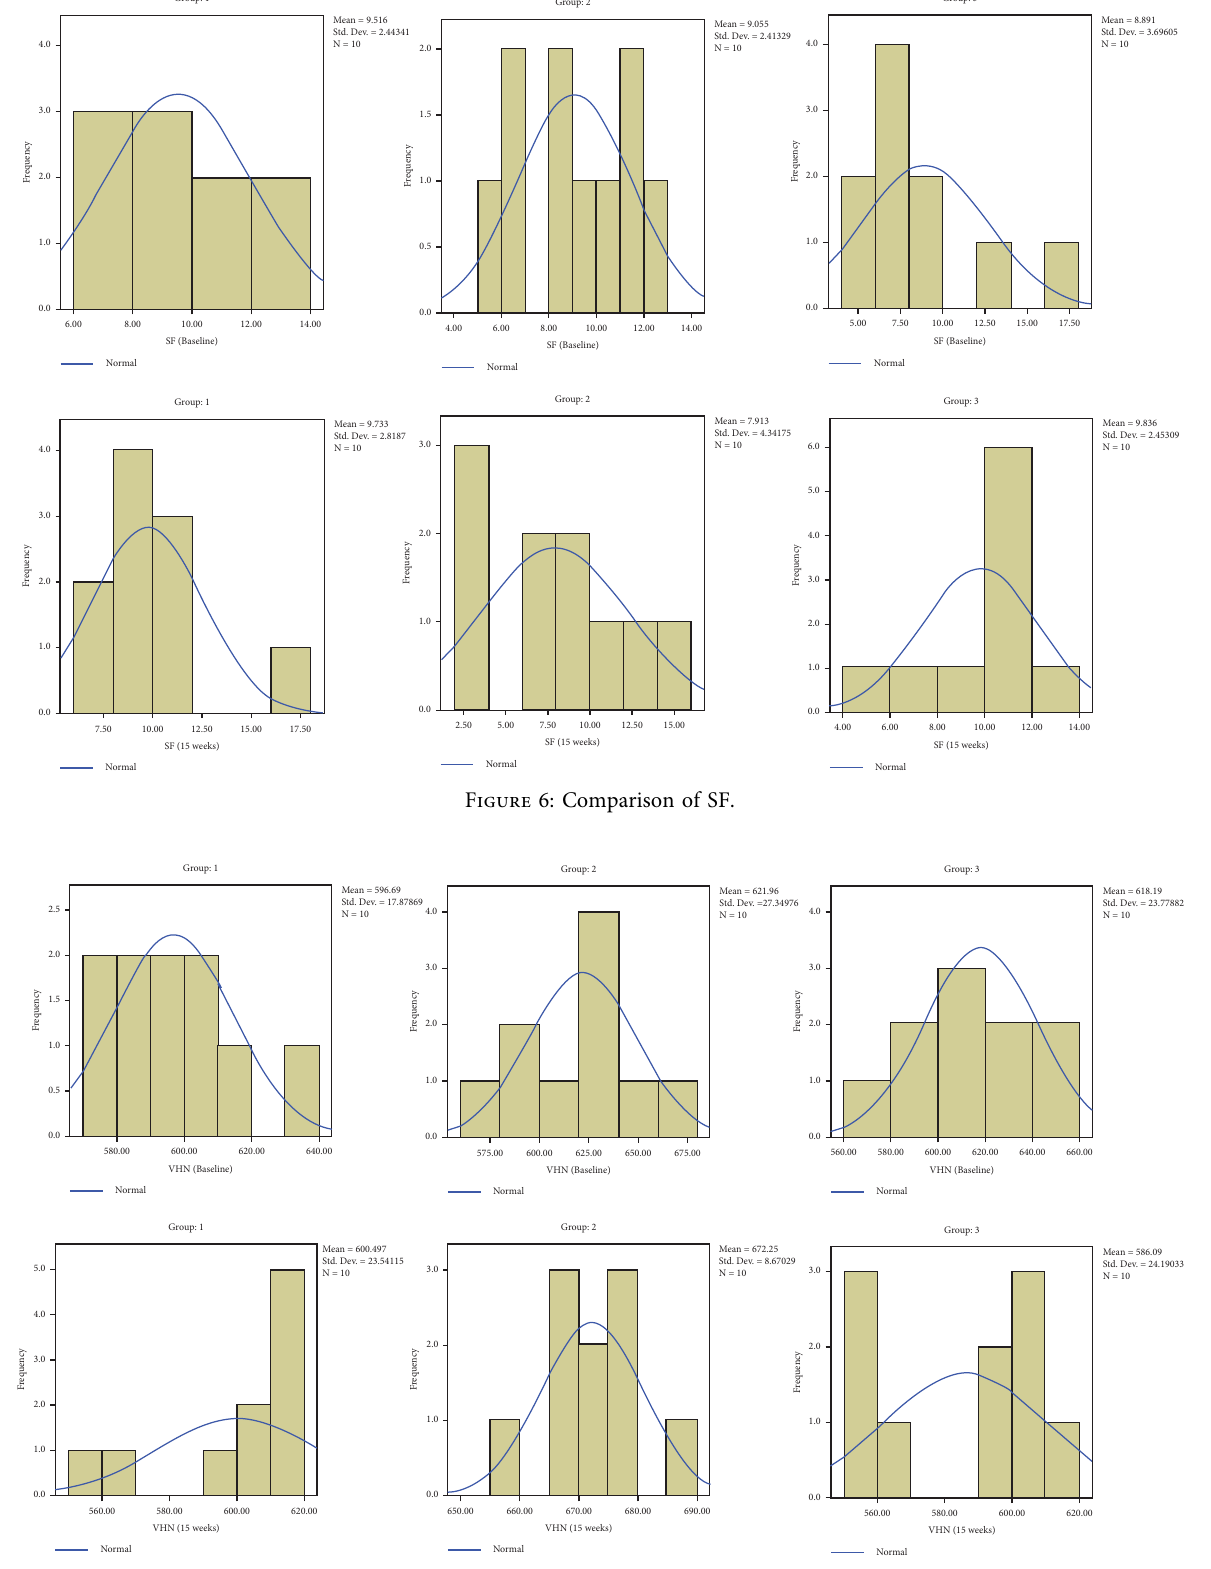
Figure 7: Comparison of